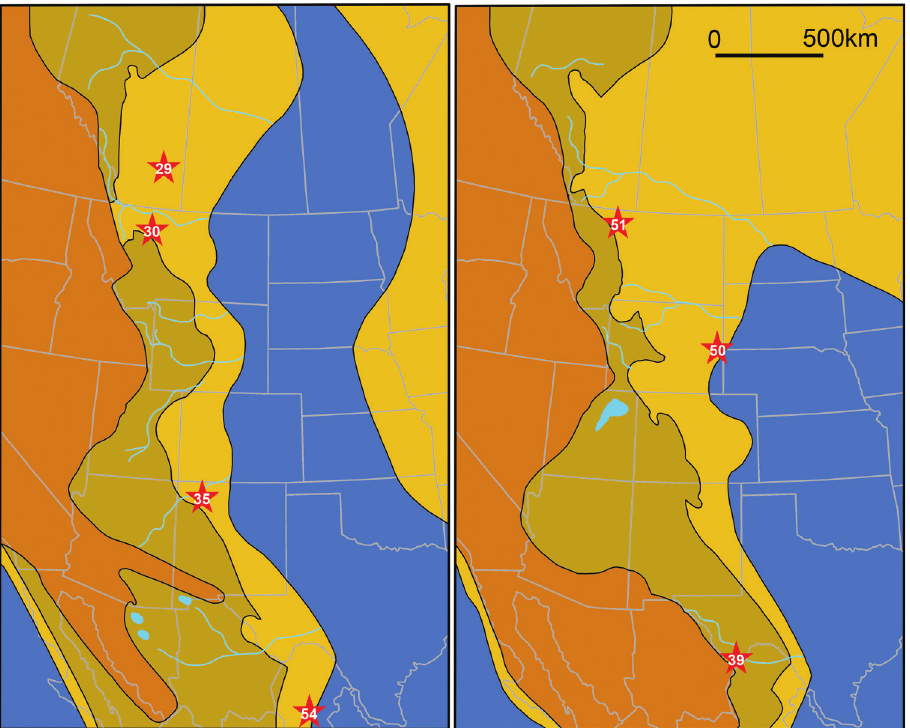
Figure 7. Paleogeographic map of middle North America for late Campanian (left) and early Maastrichtian (right) showing localities of azhdarchids. The numbers of localities correspond to the list in the text. The maps are modified from